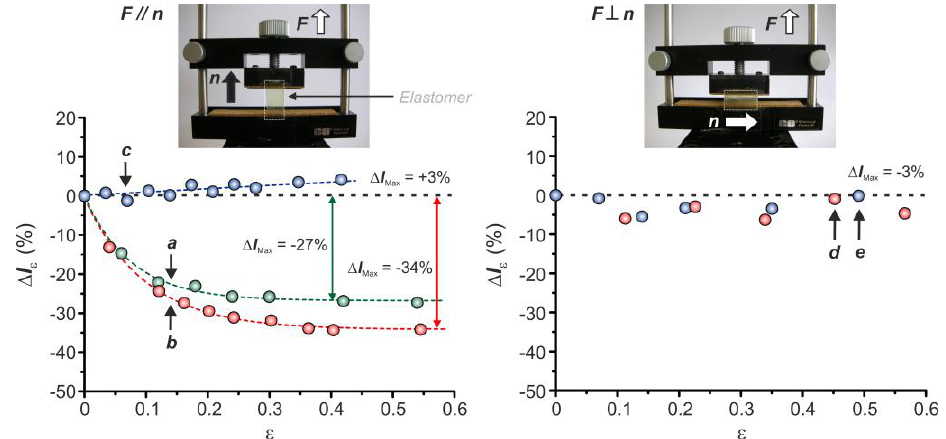
Figure 3. Mechanofluorescent response for elastomers EM4_CBZN6_5 ( a ), EM4_CBZN6_10 ( b and d ) and EM4_CBZN6_20 ( c and e ) upon deformation along the direction parallel ( a – c ) and perpendicular ( d and e ) to the longest axis of the elastomeric sample [19]. (Copyright from Wiley-VCH Verlag GmbH & Co. KGaA